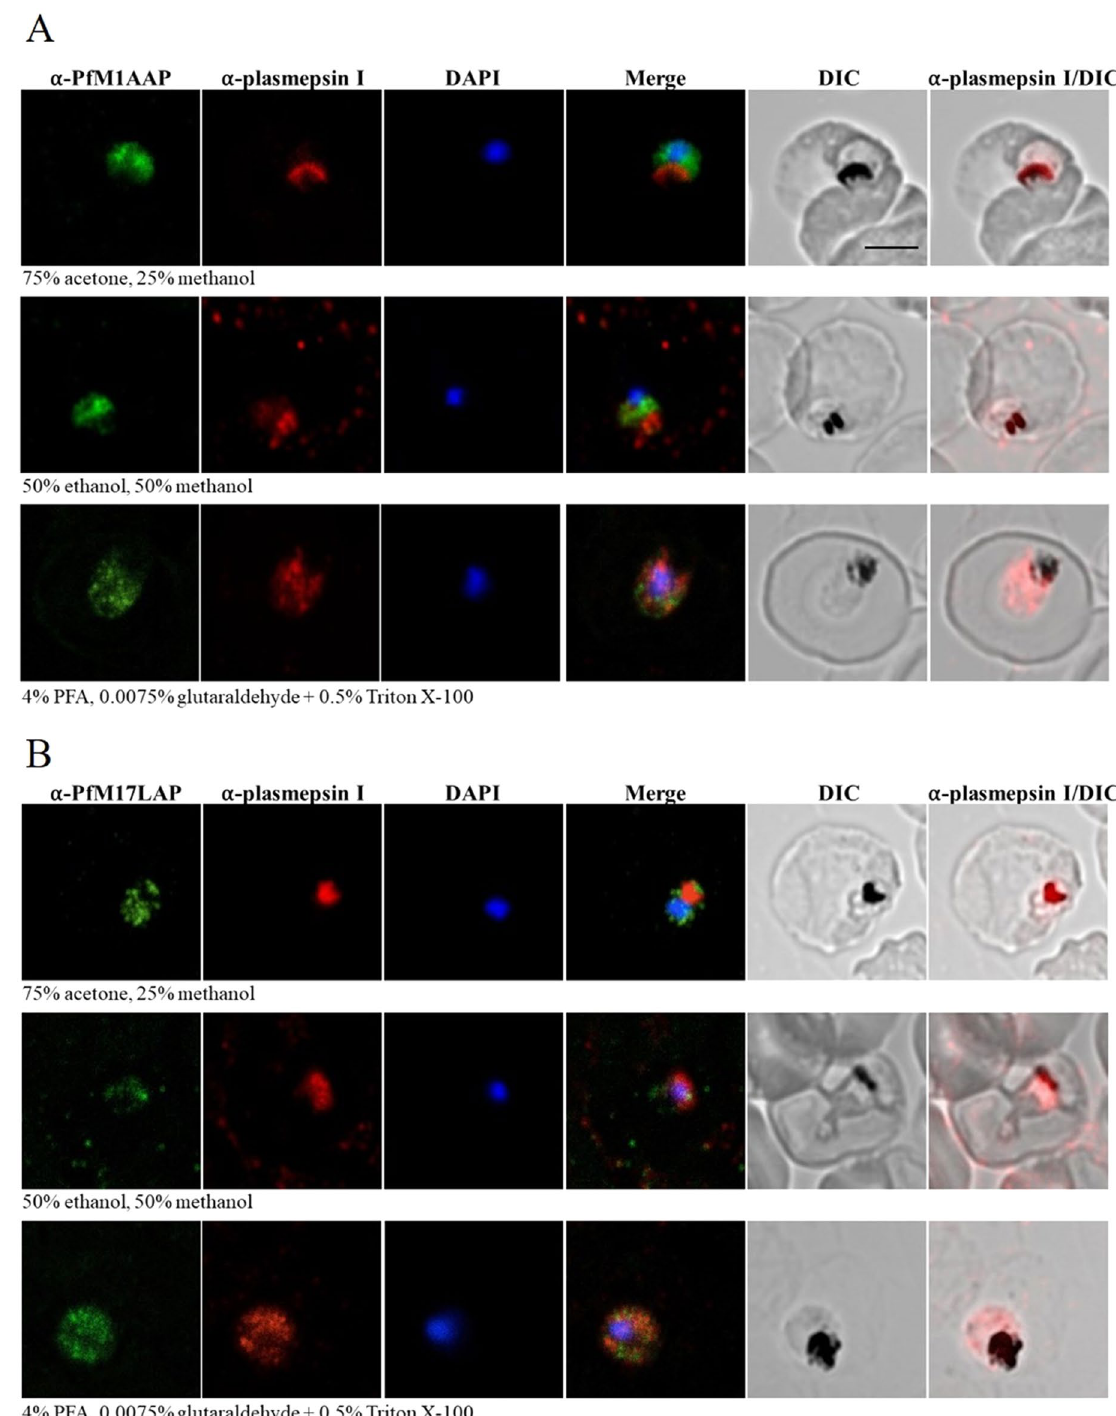
Figure 4. Localization of Pf M1AAP and Pf M17LAP in intra-erythrocytic P. falciparum 3D7 trophozoite-stage parasites. Immunofluorescence assays were carried out using air-dried blood smears fixed with 75% acetone and 25% methanol at − 20 °C for 5 min, or 50% ethanol and 50% methanol at − 20 °C for 2 min, or 4% PFA and 0.0075% glutaraldehyde for 20 min at room temperature. Fixed parasites were probed with polyclonal antibodies against ( A ) Pf M1AAP and ( B ) Pf M17LAP. Specific aminopeptidase staining (green, Alexa-Fluor 488) was observed in the cytosol of parasites. Parasite nuclei were visualized using DAPI (blue; 4,6-diamidino- 2-phenylindole) and monoclonal antibodies against the DV marker plasmepsin I (α-plasmepsin I, red, Alexa- Fluor 594) were used as a control. Differential interference contrast (DIC) and α-plasmepsin I with DIC are shown for reference. Scale bar, 3